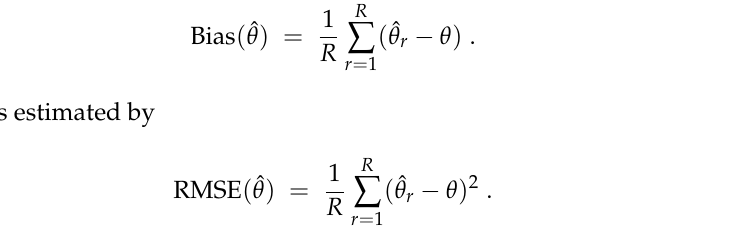
study. The specified factor loadings λ were all set to 0.7, and all error variances were set to 0.5. The latent correlation φ 12 of the factors η 1 and η 2 was set to 0.5 in the simulation. The factor variable η , as well as the residuals (cid:101) , were multivariate normally distributed. We varied the size of both residual error correlations as 0.5 · δ with δ = 0, 0.3, and